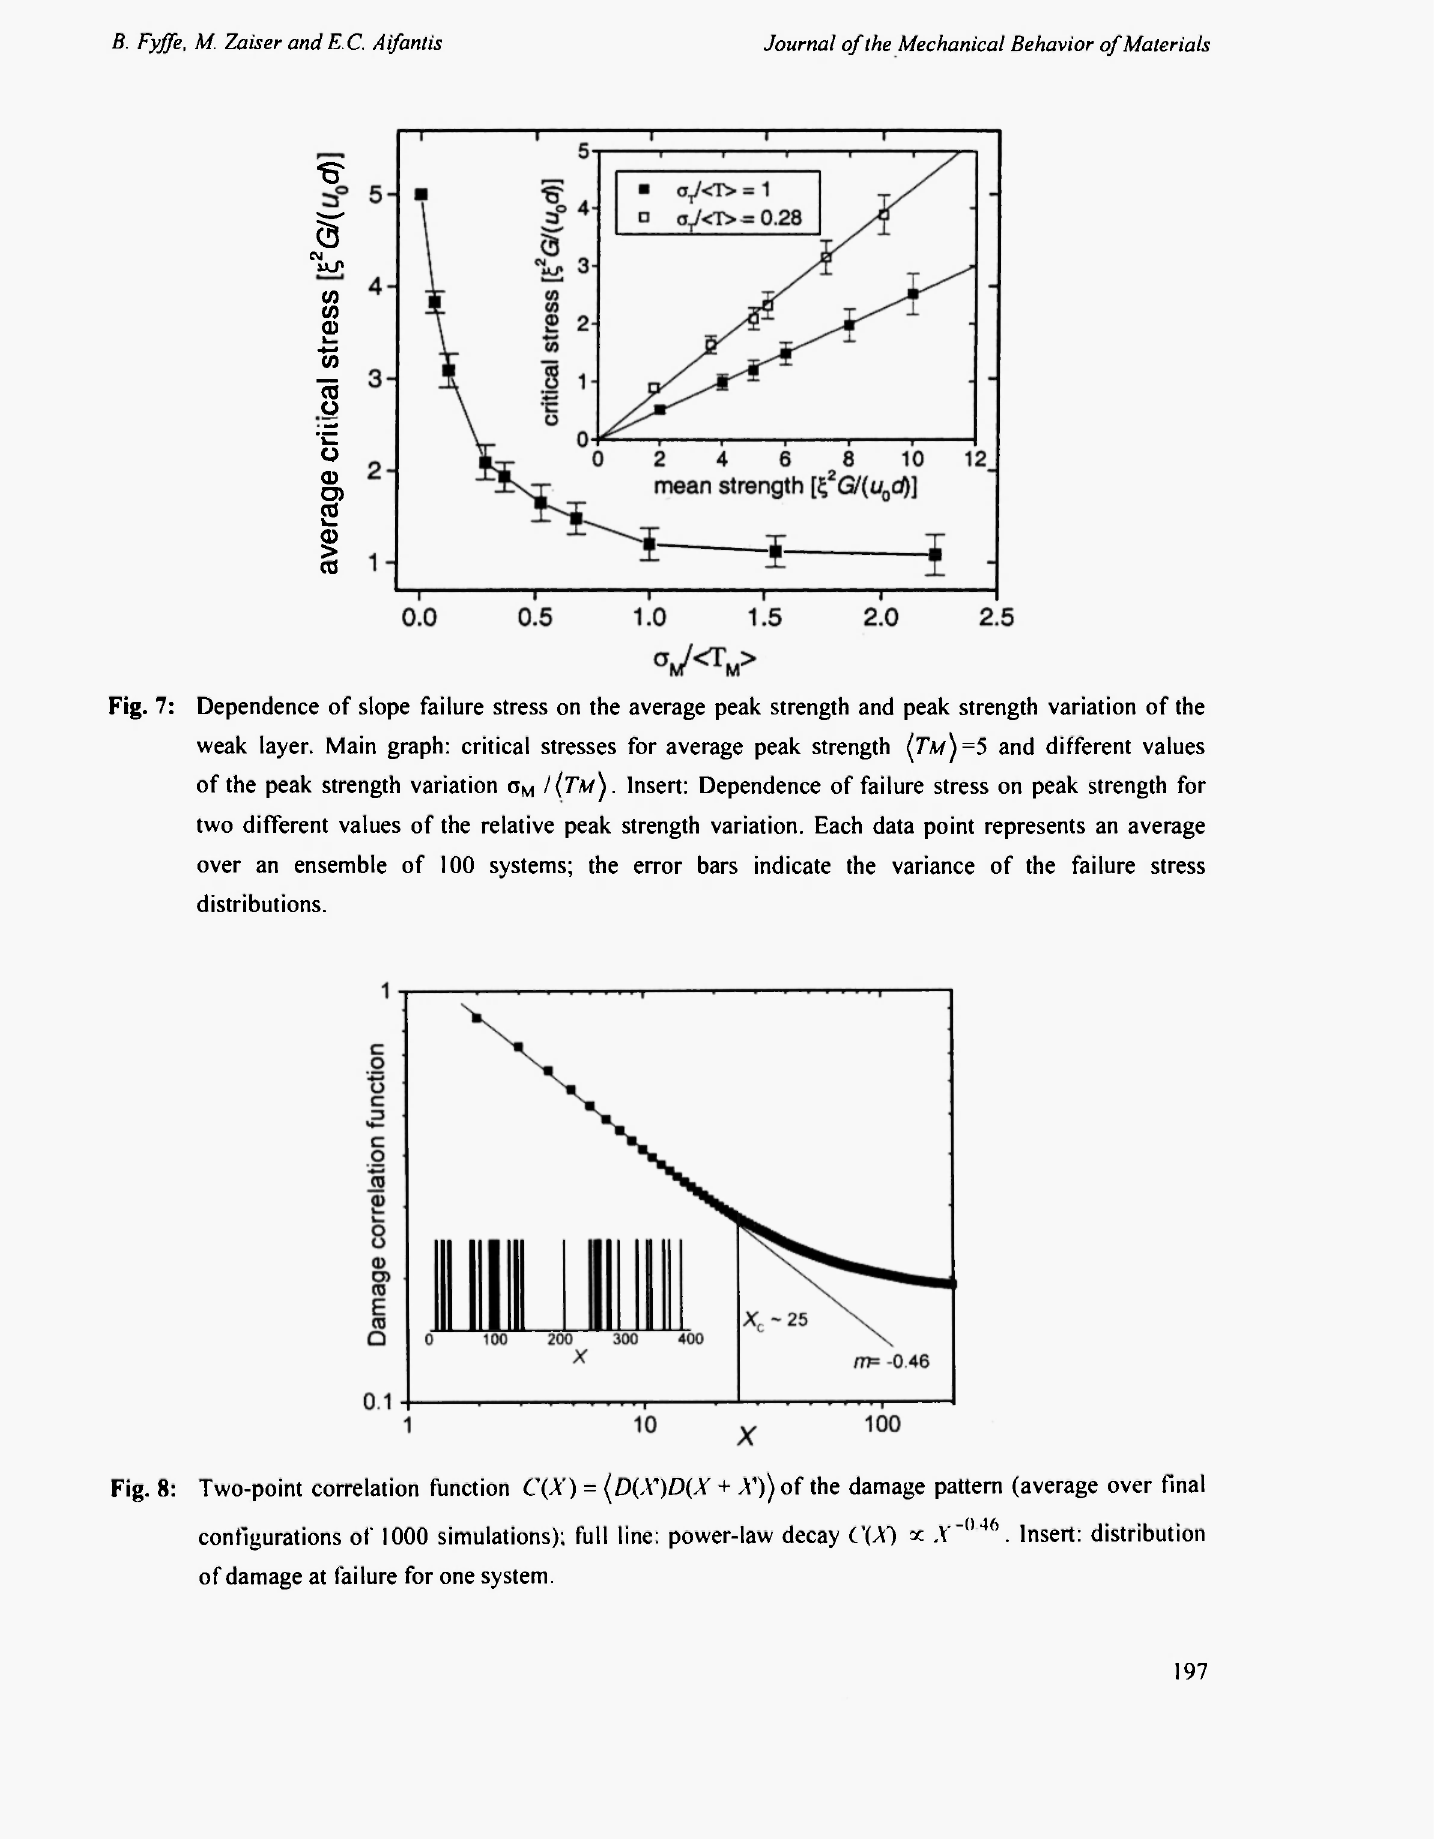
Fig. 8: Two-point correlation function C'(A') = (D(X)D(X + A , ))of the damage pattern (average over final configurations of 1000 simulations); full line: power-law decay CW χ Λ'" 046 . Insert: distribution of damage at failure for one